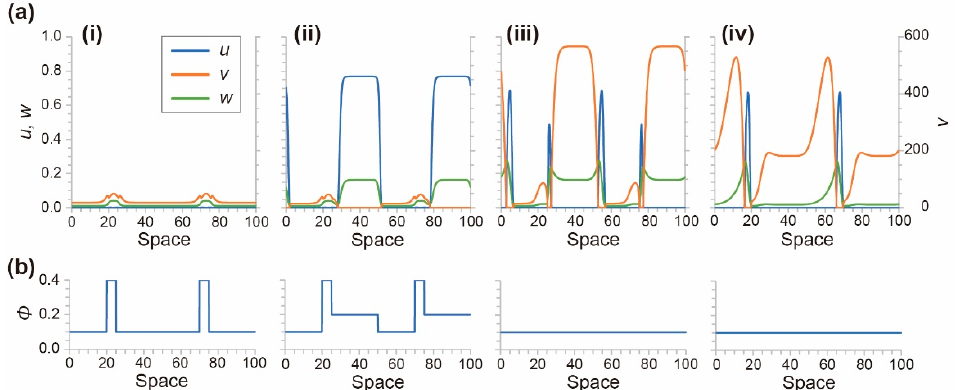
Figure 7. ( a ) Concentration profiles of u , v , and w obtained by numerical calculation. ( b ) The profile of light intensity φ ( x ) . ( i ) Steady-state with narrow light illumination within 20–25 and 70–75 ( t = − 2.0). ( ii ) Photoexcitation with wide light illumination within 25–50 and 75–100 ( t = − 0.1). ( iii ) Chemical waves were generated and traveled to the right and left ( t = 1.0). ( iv ) Chemical waves traveling to the left disappeared because of the narrow light illumination, and only unidirectional waves to the right remained ( t = 3.0).